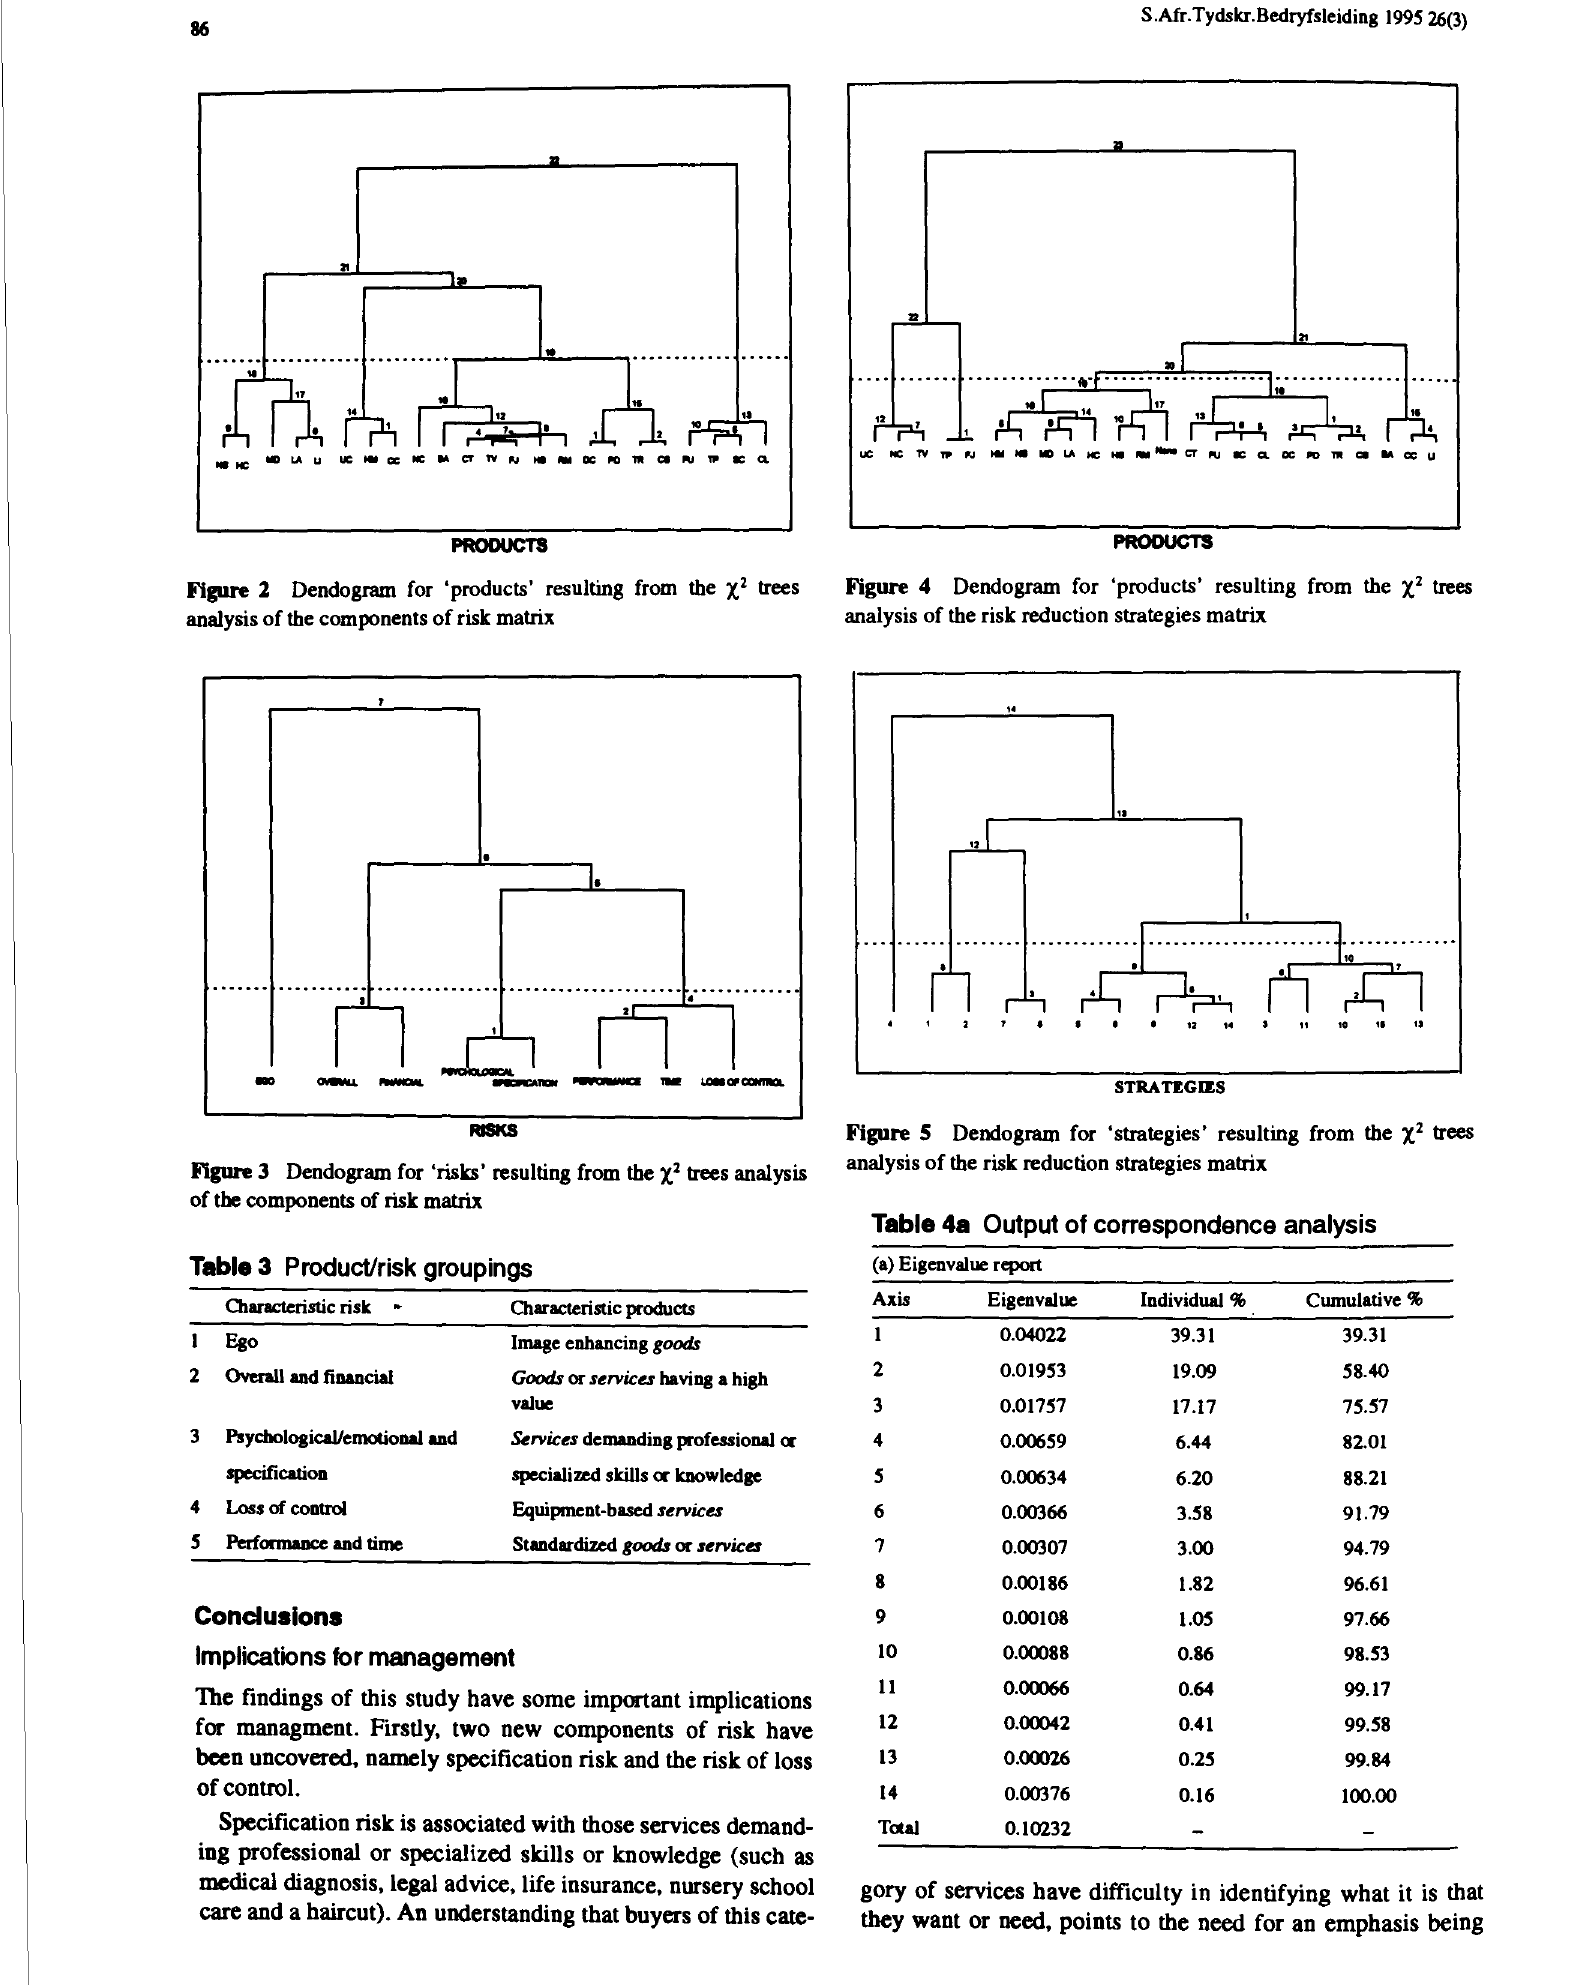
Figure 4 Dendogram for 'products' resulting from the X 2 trees analysis of the risk reduction strategies matrix